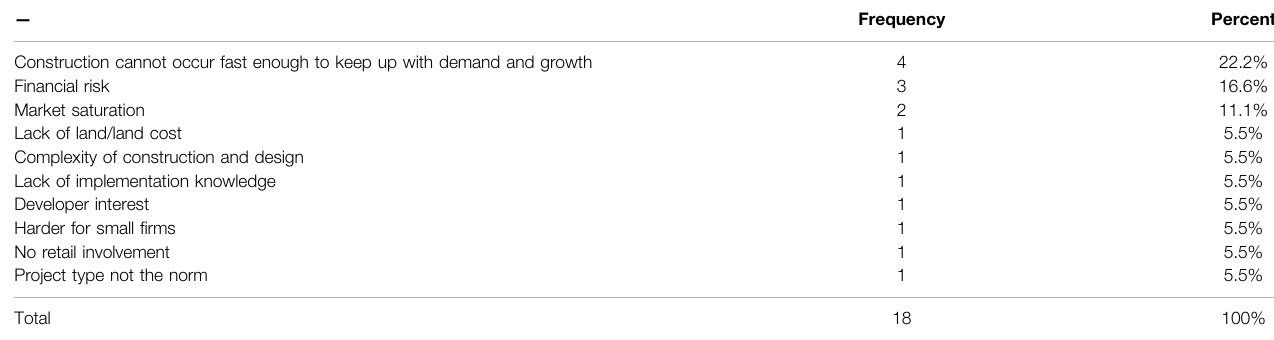
TABLE 8 | Challenges encountered described as “ other ”